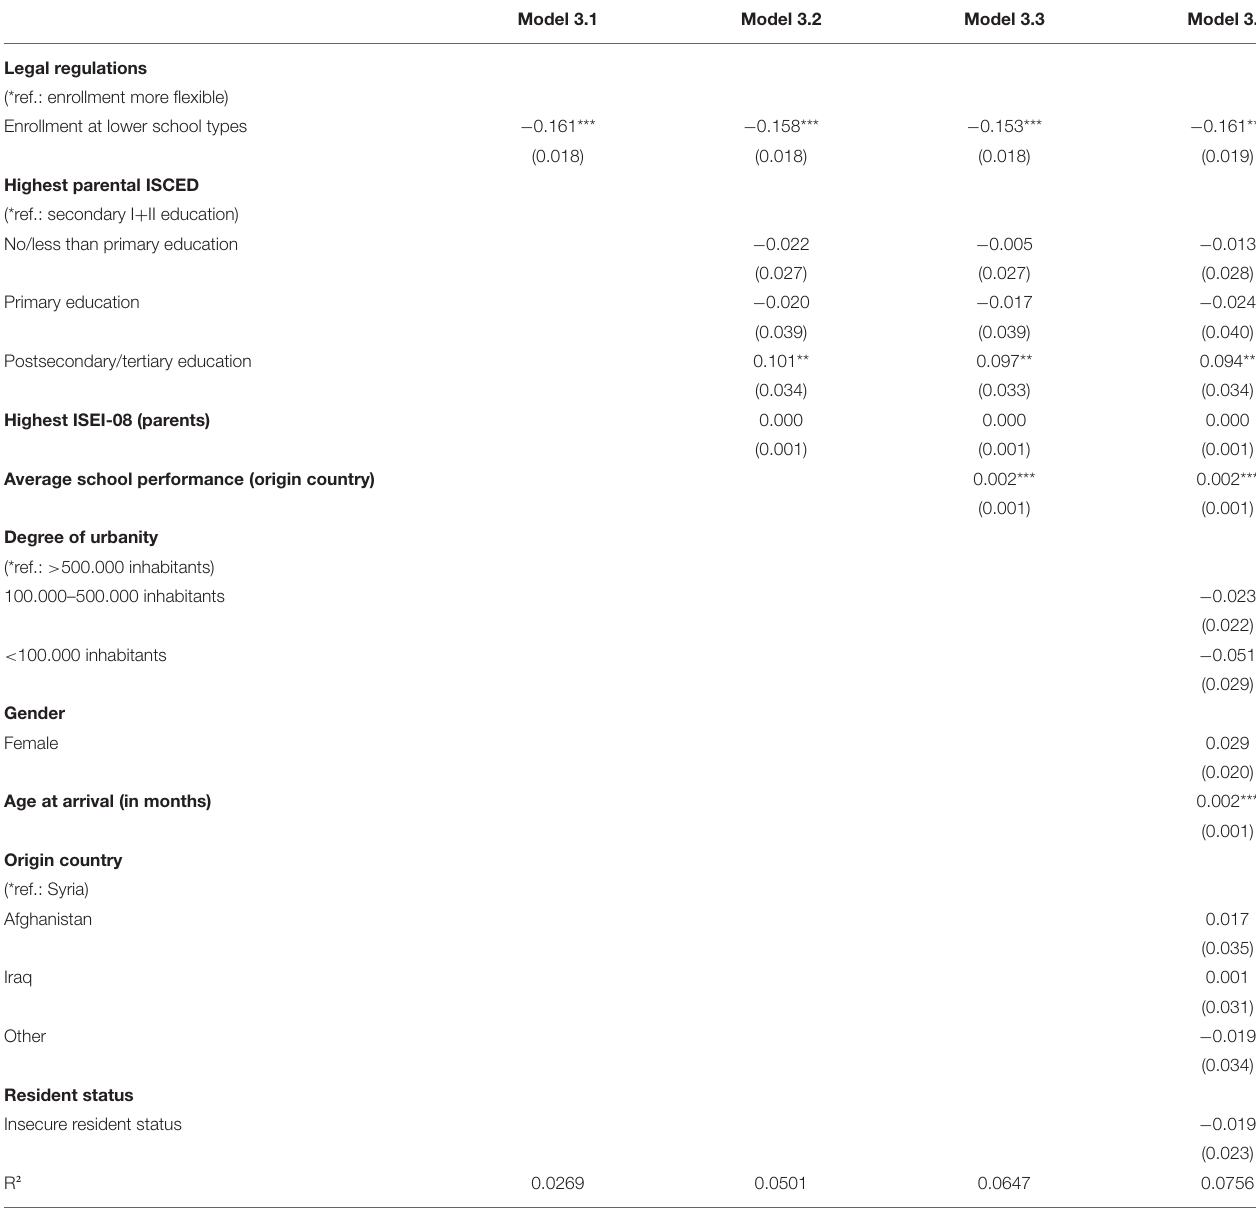
TABLE 8 | Stepwise linear probability models on attending Gymnasium as dependent variable (other school vs. Gymnasium